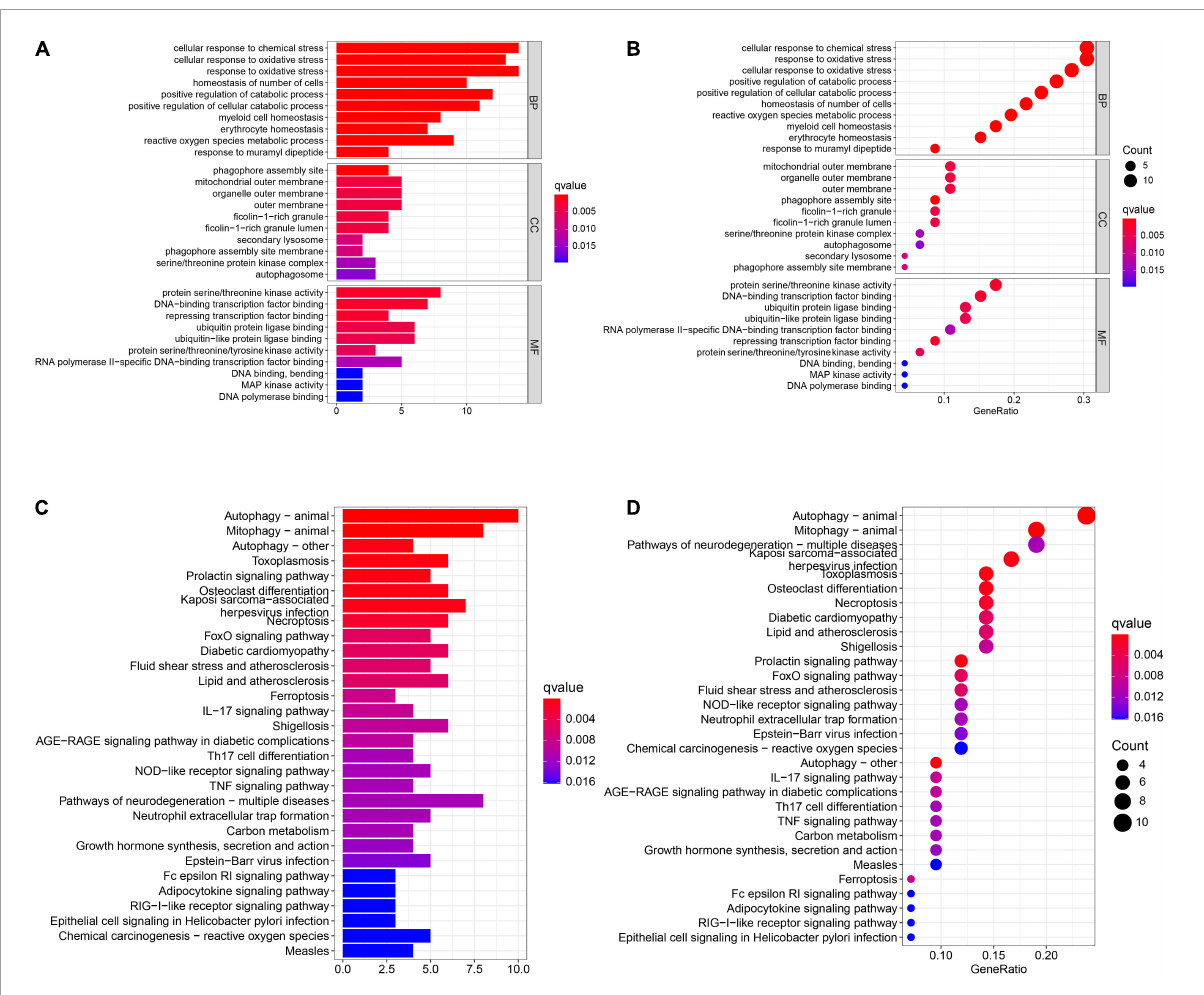
FIGURE4 The GO and KEGG analysis. The (A) bar plot and (B) bubble of GO enrichment analysis. The (C) bar plot and (D) bubble of KEGG enrichment